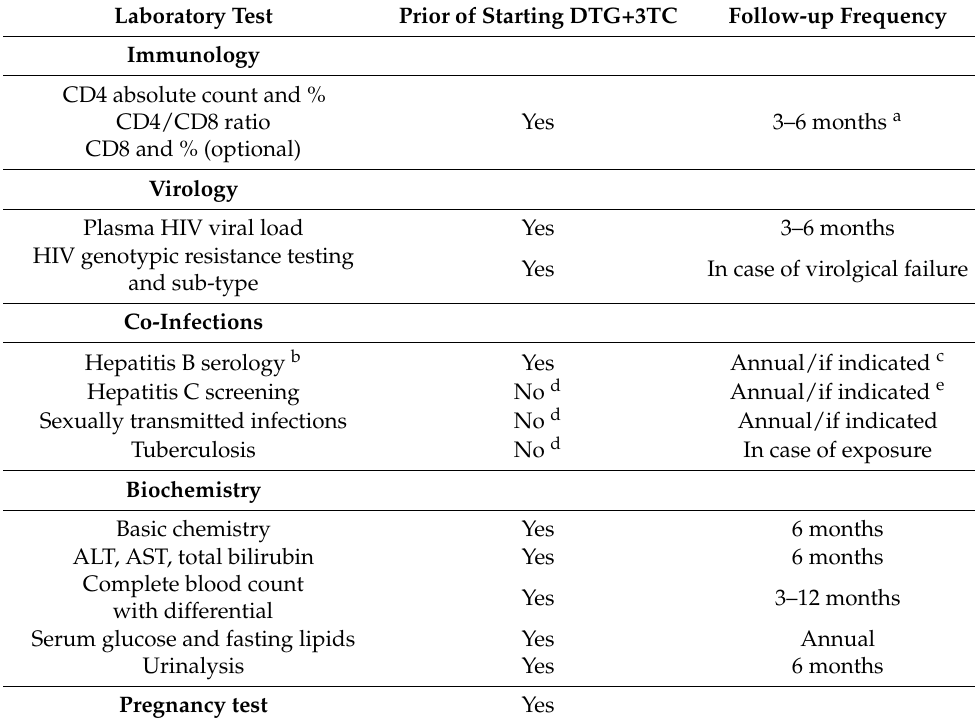
Table 2. Laboratory testing for people with HIV before and after initiation of initial antiretroviral